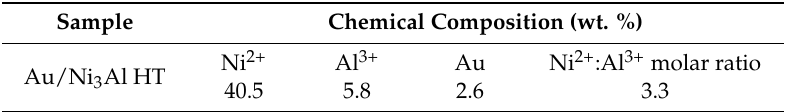
Table 1. Composition data obtained for 3 wt. % Au/Ni 3 Al HT catalysts a